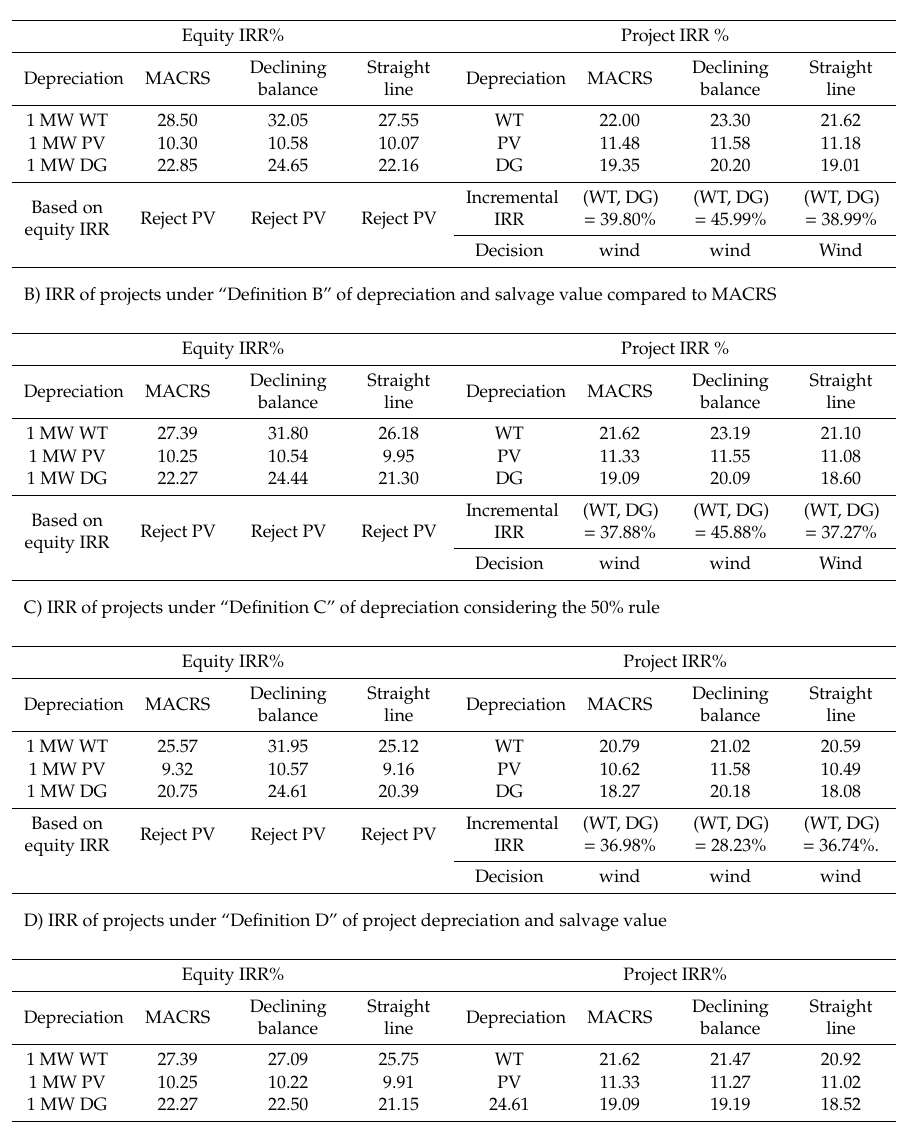
Table 7. Economic analysis of projects: a comparison with the